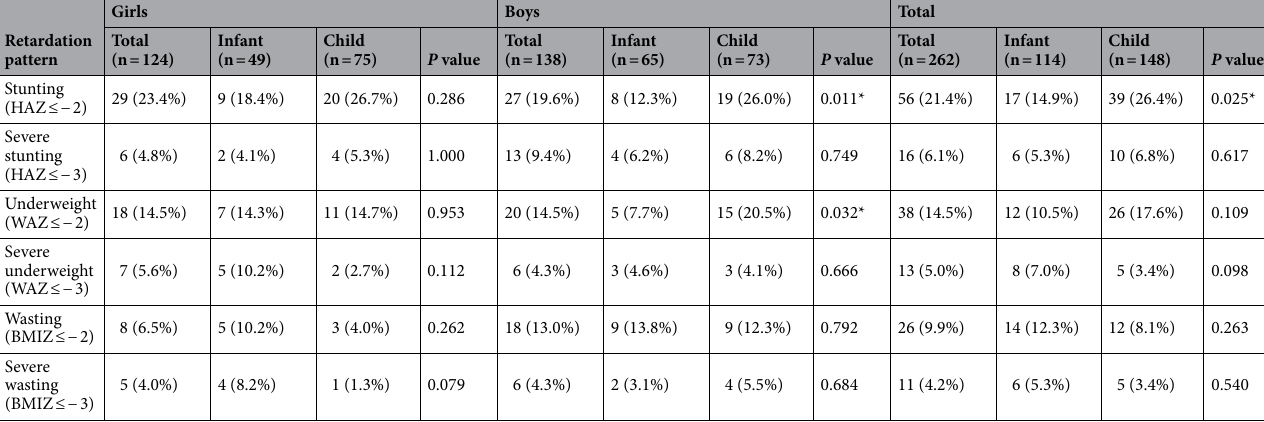
Table 2. The growth retardation frequencies of patients with TOF. Wasting frequency of infant group and child group were compared using chi-square test. P < 0.05 was considered as significant difference.